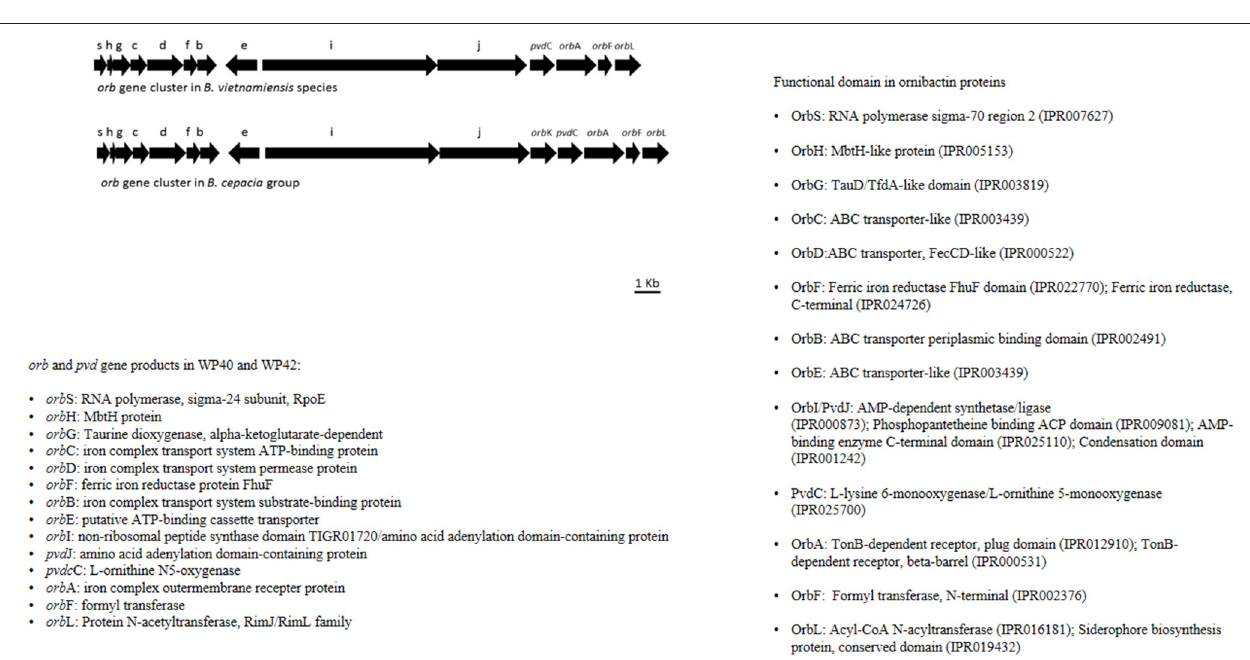
FIGURE 7 | Annotation of orb and pvd genes in WP42 [Locus tags: EX20DRAFT_02566( orb S)–02579 ( orb L)], and WP40 [Locus tags: Ga0008008_110136 ( orb S)–110149 ( orb L)], and B. cepacia